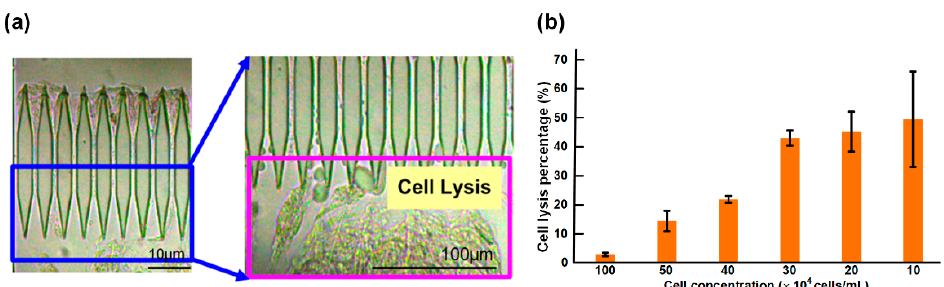
Figure 4. ( a ) Cell lysis by the chip-based microfluidic device; ( b ) cell lysis percentage by using the chip-based microfluidic device under different cell concentrations ( n = 3).